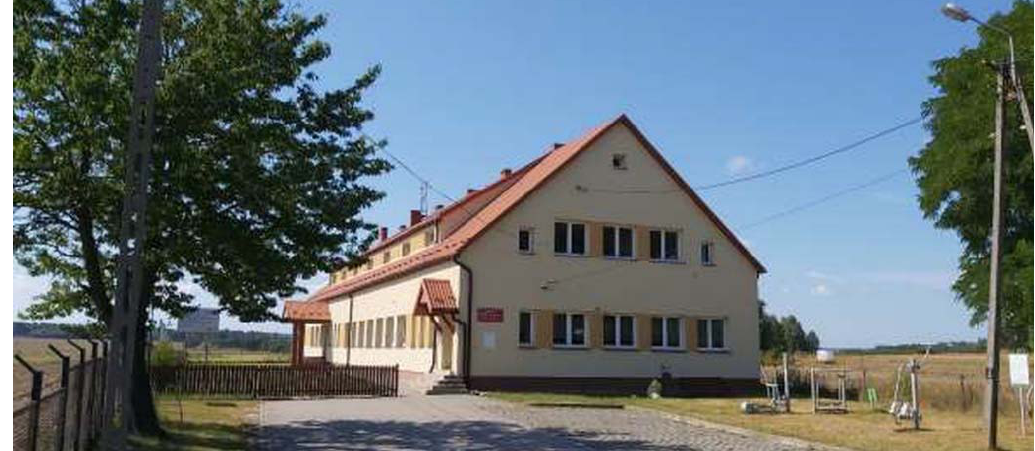
Figure 7. View of the school after modernization.